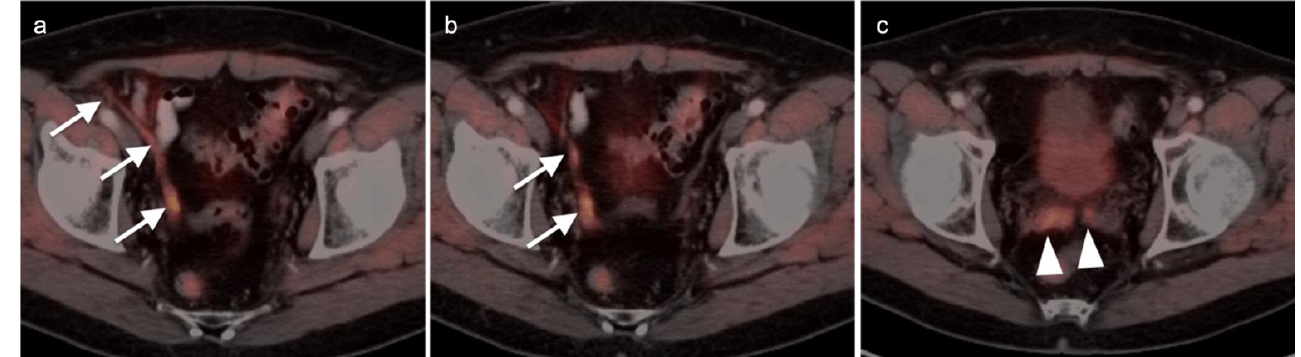
Figure 31. Extensive extra-prostatic spread of prostate cancer on PSMA PET-CT. Areas of tumor include ( a , b ) spread into the urinary bladder (white arrows); ( b ) involvement of both seminal vesi- cles (solid white arrowheads); ( c , d ) extensive involvement of the prostate; ( e ) encasement of the proximal urethra (open white arrowhead); ( d ) MIP PSMA PET mage of the pelvis shows the exten- sive extra-prostatic involvement and two small involved bilateral pelvic lymph nodes.